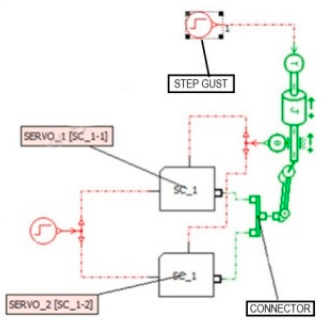
Figure 8. Simulation scheme for the gust behavior of the system.